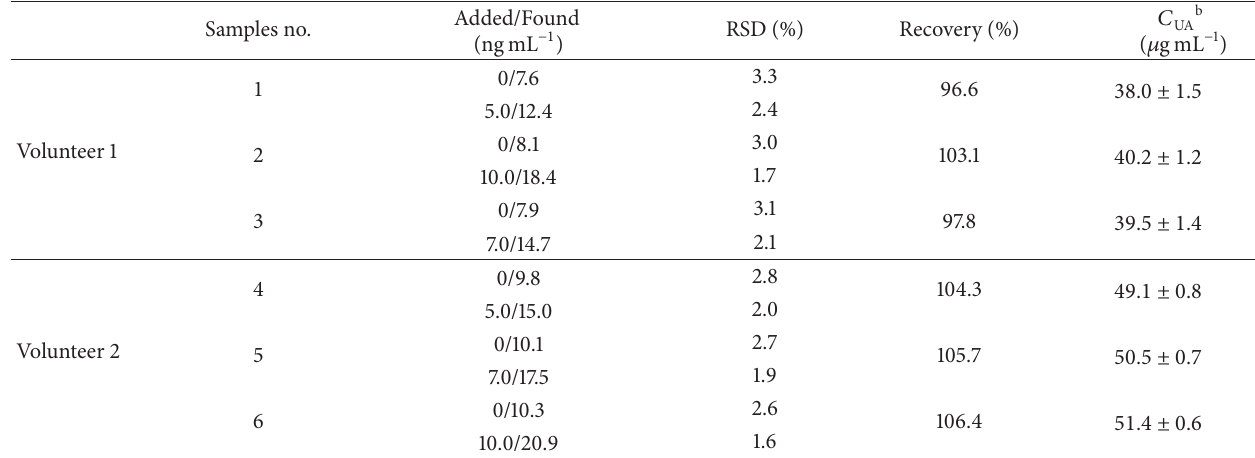
Table 3: Determination for UA in human serum samples a .